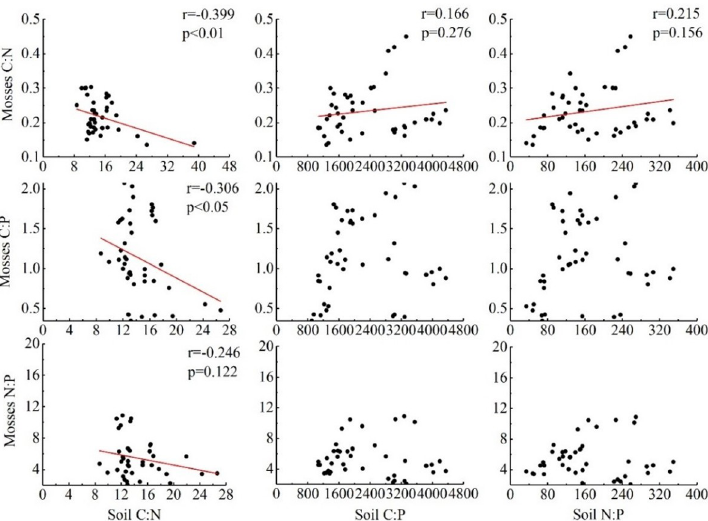
Fig 4. Correlation analysis between C, N, and P contents of mosses and soil and stoichiometric ratios in karst rocky desertification areas.